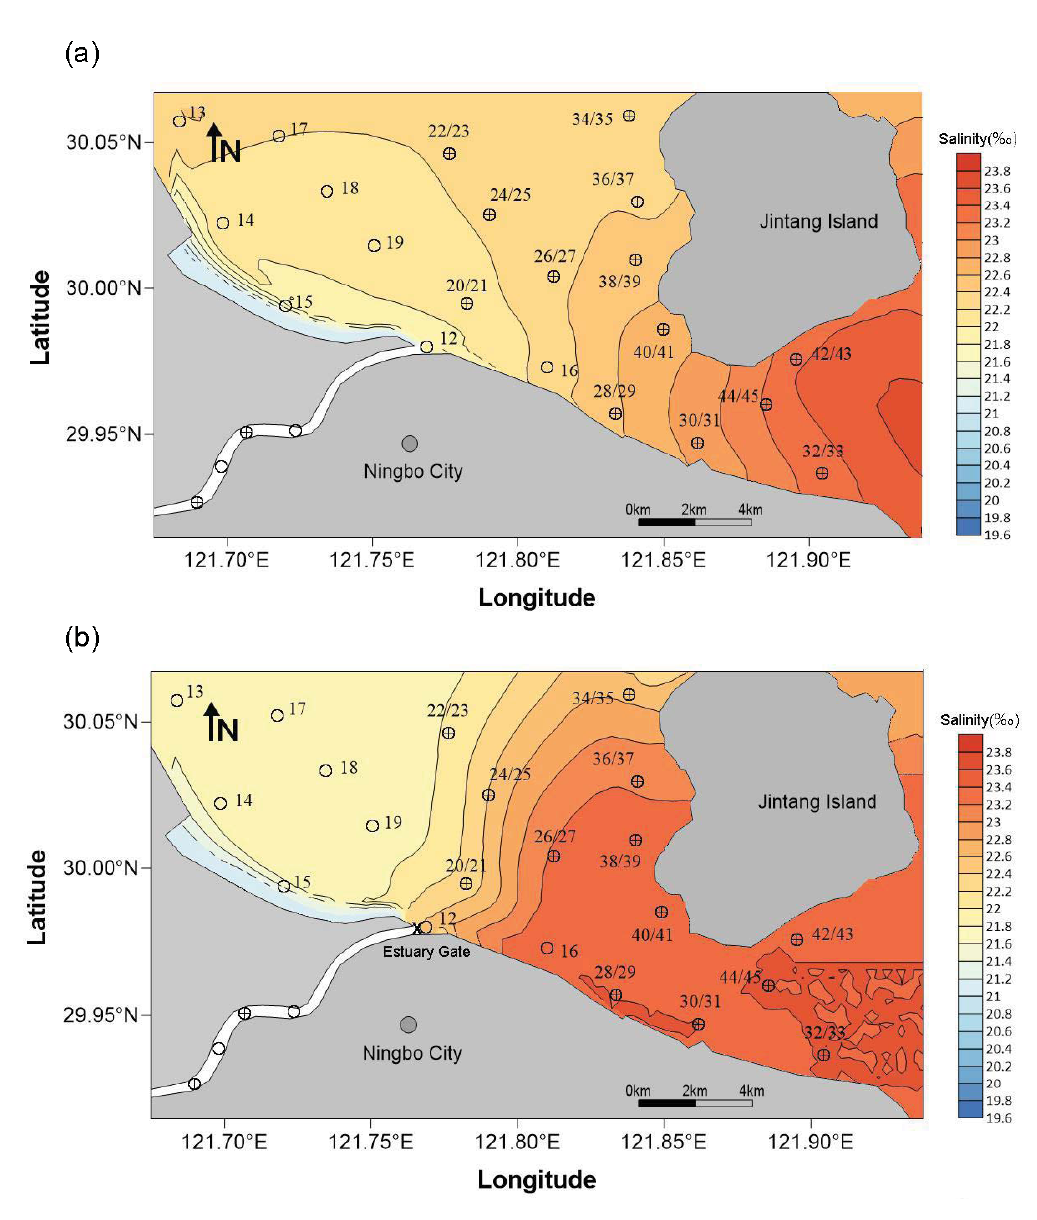
Figure 6. Contour map of salinity: ( a ) Contour map of salinity drawn with the measured data; ( b ) Contour map of salinity generated with the simulated data when a gate was added at the entrance to the estuary. See Figure 2 for detailed information about sampling locations and